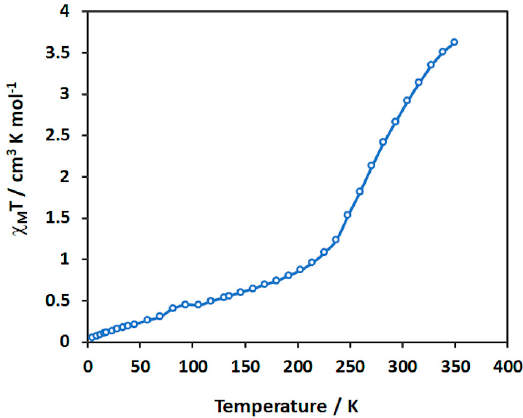
Figure 7. VSM profiles of fac -[Fe(4-ima-Bp) 3 ](Y) 2 ⋅ sol as χ M T vs. T plots of a) 1 (green), b) 2 (red), c) 3 (blue) and d) 4 (black).